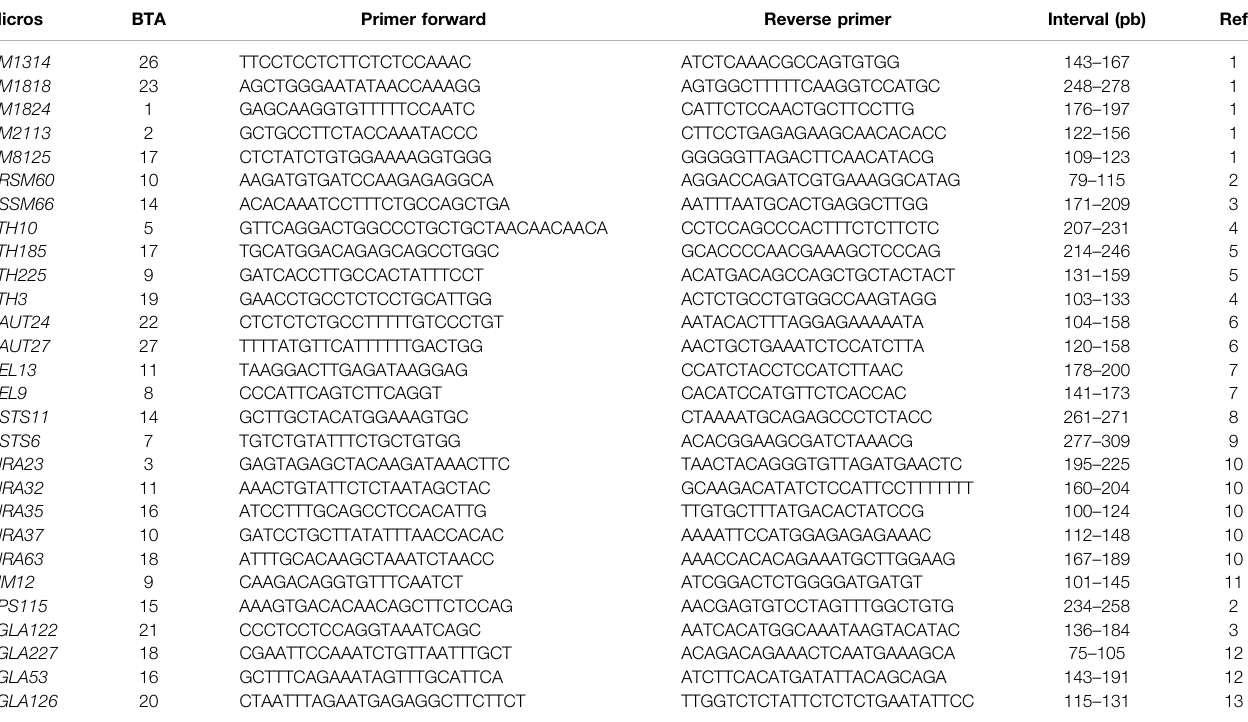
TABLE 1 | Microsatellites used in the breed characterization of Curraleiro Pé-Duro.